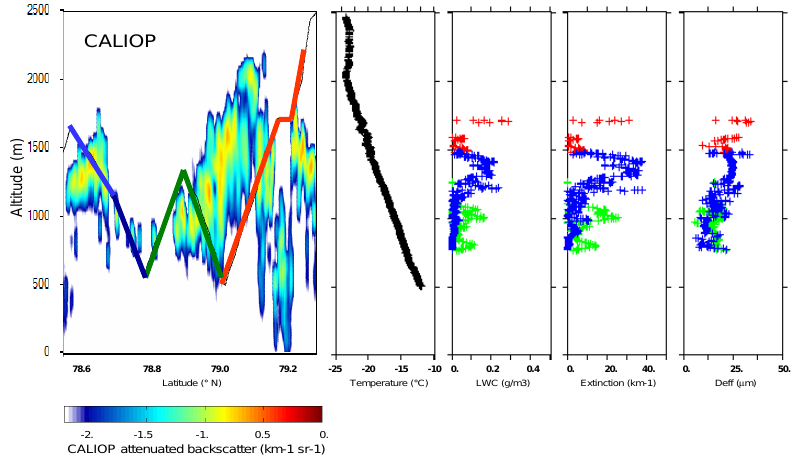
Fig. 3a. CALIOP attenuated backscatter profile (532nm channel) at 10:06UT along the satellite track represented on Fig. 1 between latitudes 78.55 ◦ N and 79.25 ◦ N. In colored line is superimposed the Polar-2 flight altitude. The four panels display the vertical profiles of the following parameters obtained during the Polar-2 ascent-descent sequences: air temperature, liquid water content, extinction coefficient and the effective diameter respectively. The symbols are colored according to the flight